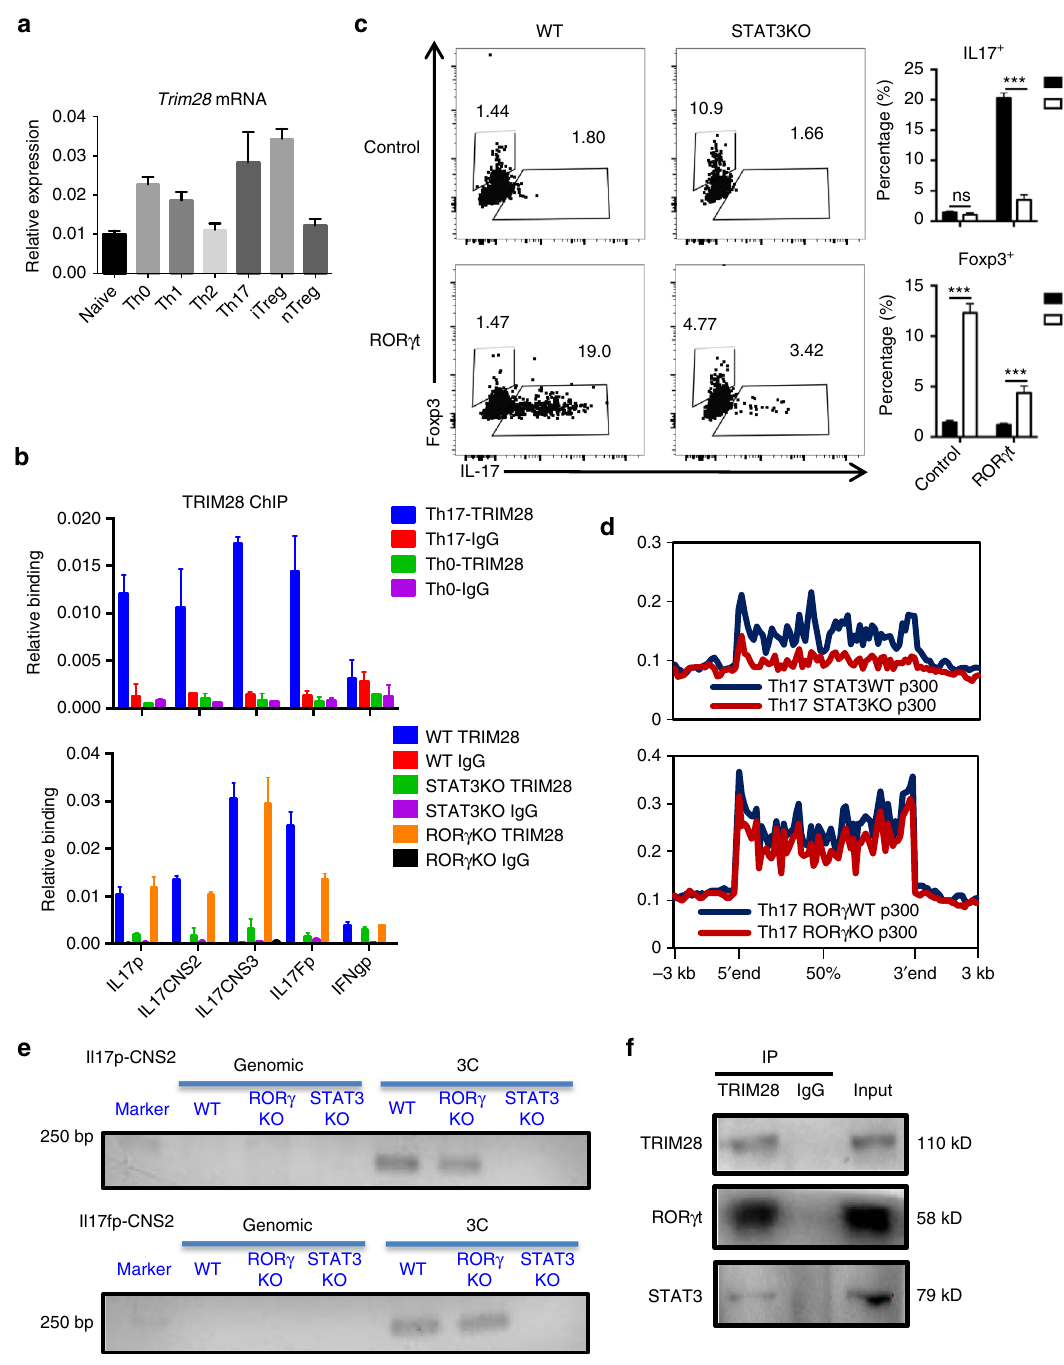
Fig. 7 Cytokine signaling regulated TRIM28 recruitment. a Expression of TRIM28 in different T-cell subsets and naive CD4 + T cells. b TRIM28 ChIP-qPCR results in WT Th0, WT Th17, STAT3 KO Th17 or ROR γ t KO Th17 cells. c ROR γ t overexpression in WT or STAT3 KO CD4 + T cells polarized under neutral (Th0) condition. d Overlay of p300 binding peaks in WT/STAT3KO(Upper) or WT/ROR γ KO (lower) Th17 cells over Th17-speci fi c SEs with decreased p300 intensity. e 3C-PCR experiments were performed in WT and TRIM28KO Th17 cells cultured for 3 days and the PCR products were acquired by nest PCR. M is short for marker, and the whole DNA gels are shown in Supplementary Fig. 8. f Immunoblot results of TRIM28 immunoprecipitated protein complexes as detected by ROR γ t and STAT3 antibodies in Th17 cells. The whole WB gels are shown in Supplementary Fig. 9. Those experiments were repeated twice with consistent results, and Student ’ s t test was used for the statistical test (ns = not signi fi cant; * p < 0.05, ** p < 0.01, *** p < 0.005). All error bars represent